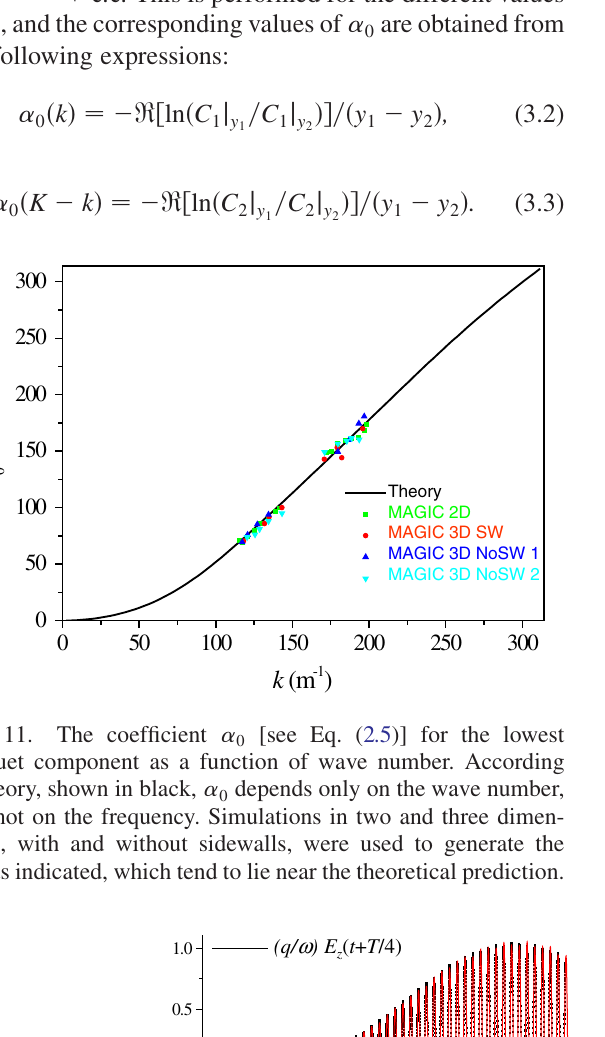
and E ; (b) B and E . y z z y